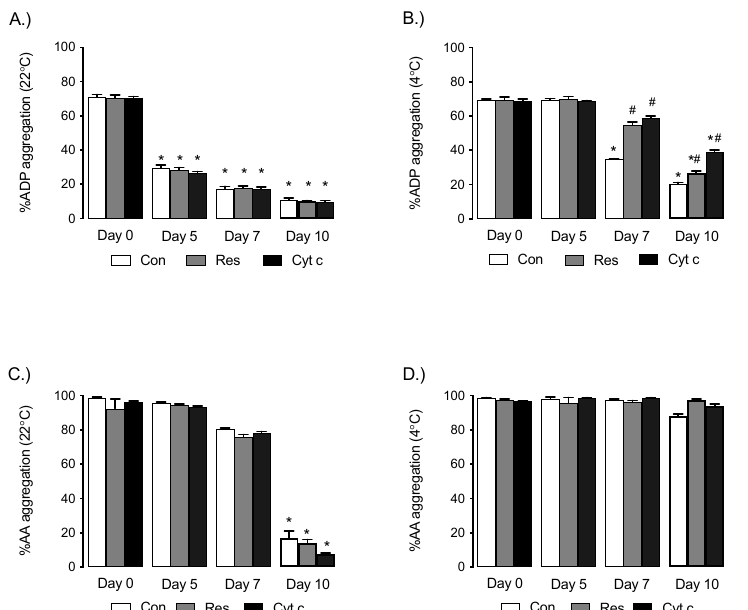
Figure 1. ( A ) ADP-induced platelet aggregation declines during storage in control, Cyt c and Res supplemented groups at 22 °C on day 5, day 7 and day 10 versus day 0. * p < 0.05 versus treatment-matched day 0, n = 4 independent experiments. ( B ) Decline in ADP-induced platelet aggregation is lessened by Res and Cyt c supplementation compared to untreated platelets. * p < 0.05 versus treatment-matched day 0, # p < 0.05 treatment group versus control (Con) at same time point, n = 4 independent experiments. ( C ) AA-induced aggregation declines during storage at 22 °C on day 10 versus day 0. * p < 0.05 versus treatment-matched day 0, n = 4 independent experiments. ( D ) AA-induced aggregation is not affected by storage at 4 °C or by supplementation with Res or Cyt c ( n = 4 independent experiments).